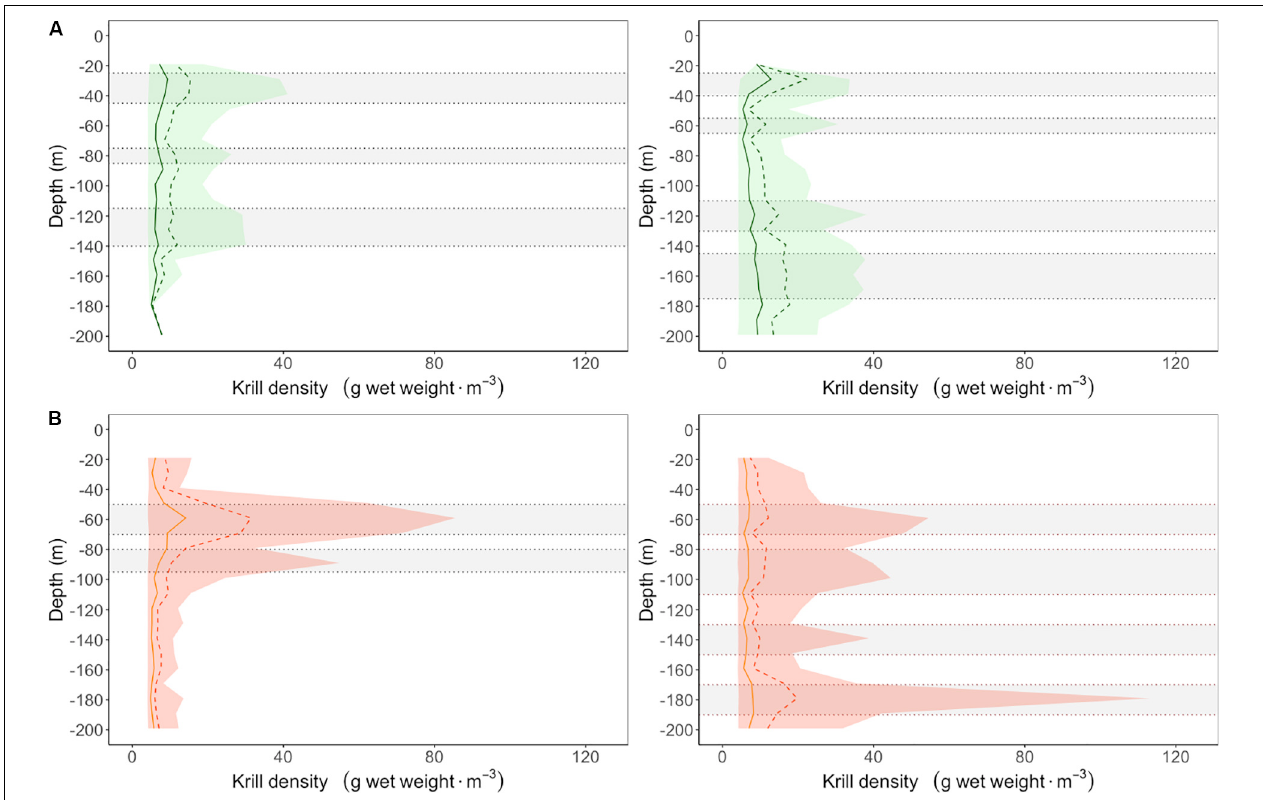
FIGURE 3 | Vertical density profiles for (A) Thysanoessa spp. (green) and (B) Meganyctiphanes norvegica (orange) for the St. Lawrence Estuary (left) and the northwestern Gulf of St. Lawrence (right) with identified high density layers used as targeted feeding depth for simulated dive time-series (gray horizontal ribbons). Solid vertical lines represent the median, the dashed lines are the 75th percentiles and the colored areas are the 5–95%